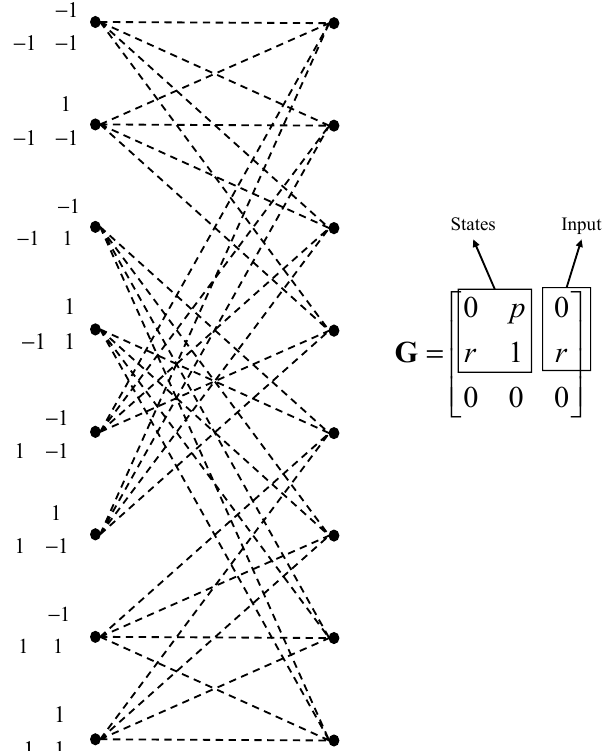
Figure 3. Trellis for the detection of the 2-way GPR target.